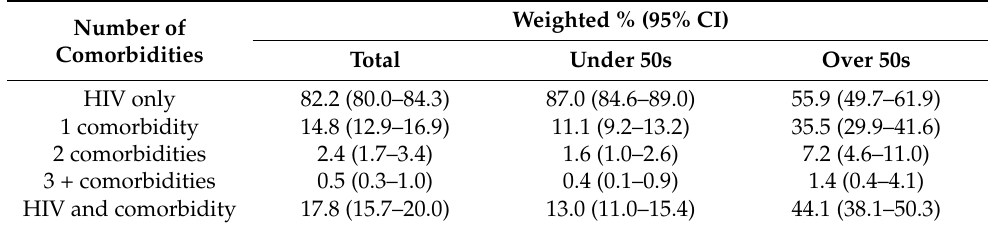
Table 2. Prevalence of comorbidities in adults living with